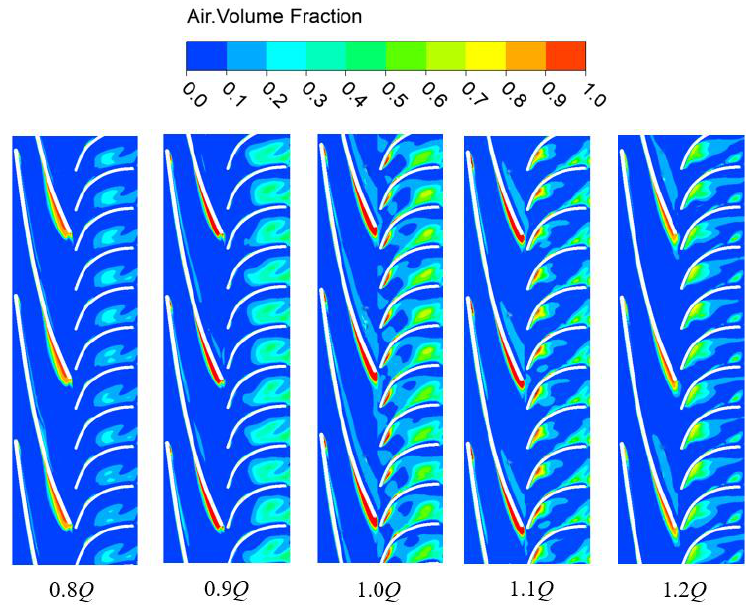
Figure 13. Circumferential gas-phase volume fraction distribution of pressurization unit of multi- phase pump under different flow conditions for gas – liquid two-phase media.